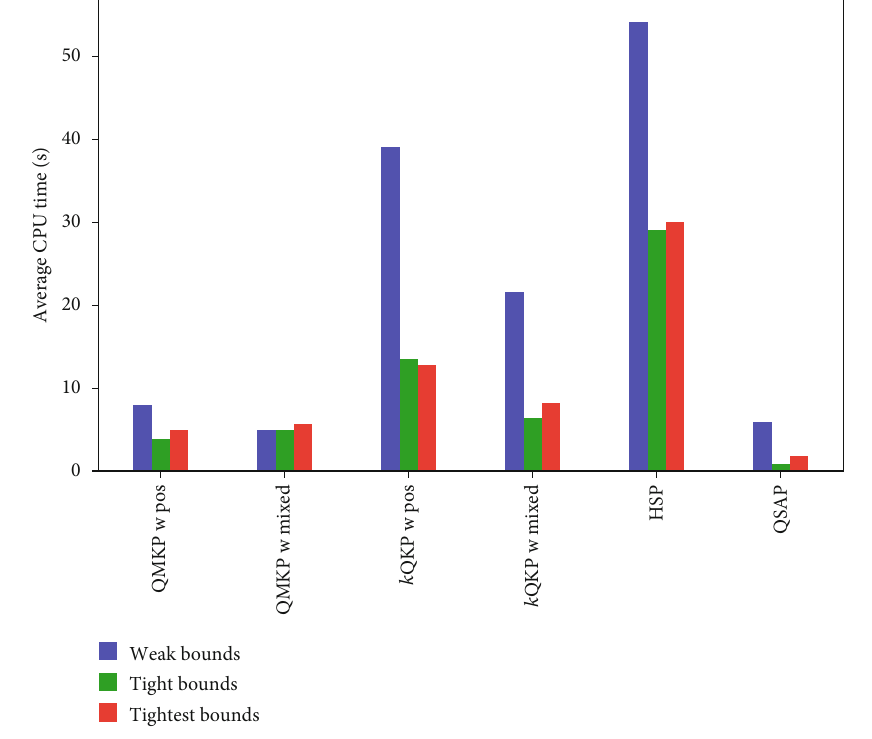
Figure 8: Average CPU times (s) for Question 3. Table 1: Summary of answers to Questions 1 through